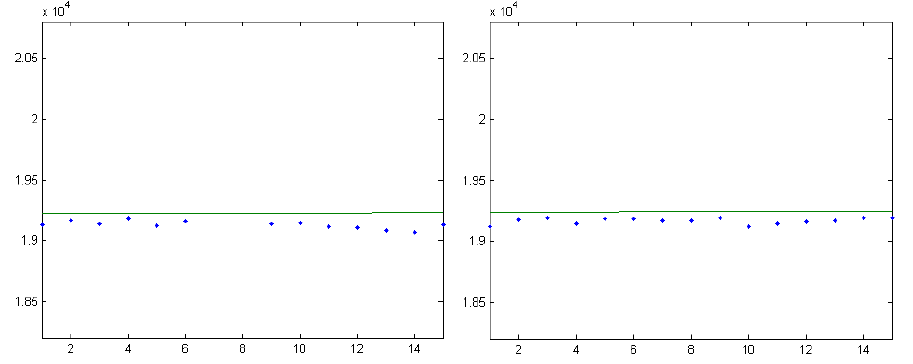
Figure 17. Measurement results for the observed GLONASS satellites, in the SAO37985 sky area. GLONASS 733, left, and GLONASS 738,